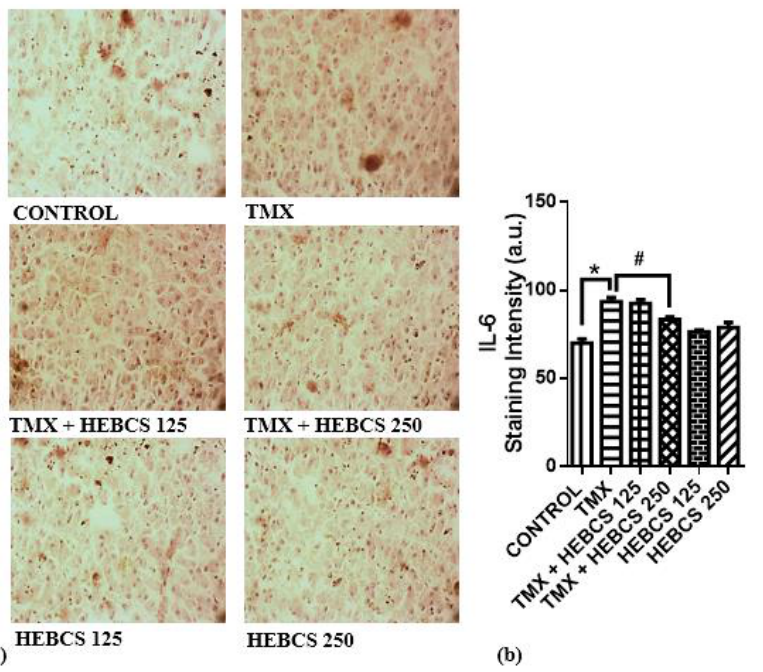
Figure 8. Immunohistochemistry slides ( × 200) ( a ) showing the hepatic expression of IL-6 in rats. Bar chart in ( b ) shows the staining intensity of each slide. Staining intensity of positive areas was measured using ImageJ. Data are presented as mean ± SD ( n = 6). * p < 0.05 Control versus other groups; # p < 0.05 TMX versus HEBCS groups. IL-6: interleukin-6; TMX: Tamoxifen; HEBCS 125 and 250: Hydroethanolic Extract of Buchholzia coriacea Seeds, 125 and 250 mg/kg body weight.